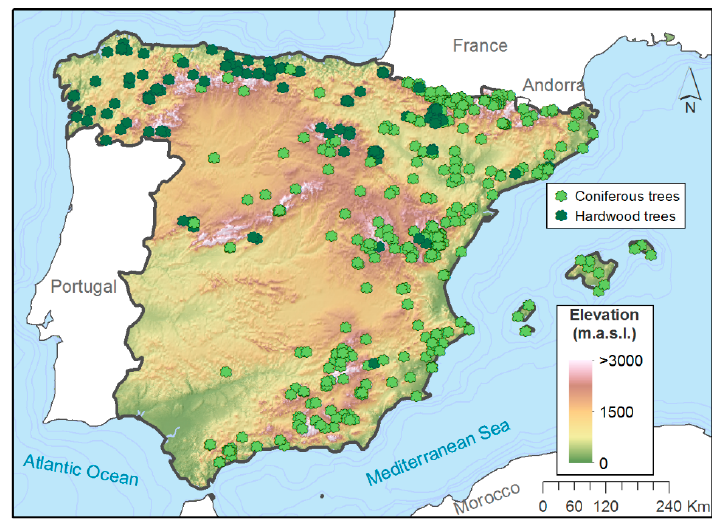
Figure 1. Location of the sampled forest stands in the study domain. Note that the conifer forests ( n = 408 sites) dominate in the driest regions (Mediterranean climate) of Eastern and Southeastern Spain, and also in mountainous terrain, while hardwood forests prevail in the wettest and temperate regions (Atlantic climate) in Northwestern and Northern Spain ( n = 160